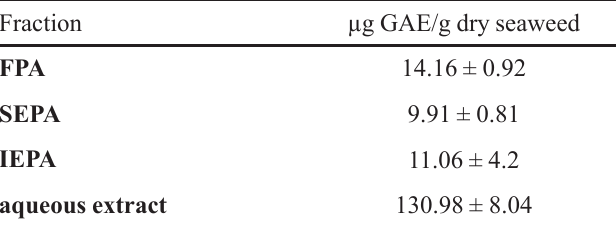
TABLE I - Phenolic content (µg total phenolics/g dry seaweed) in polar fractions obtained from seaweed Halimeda